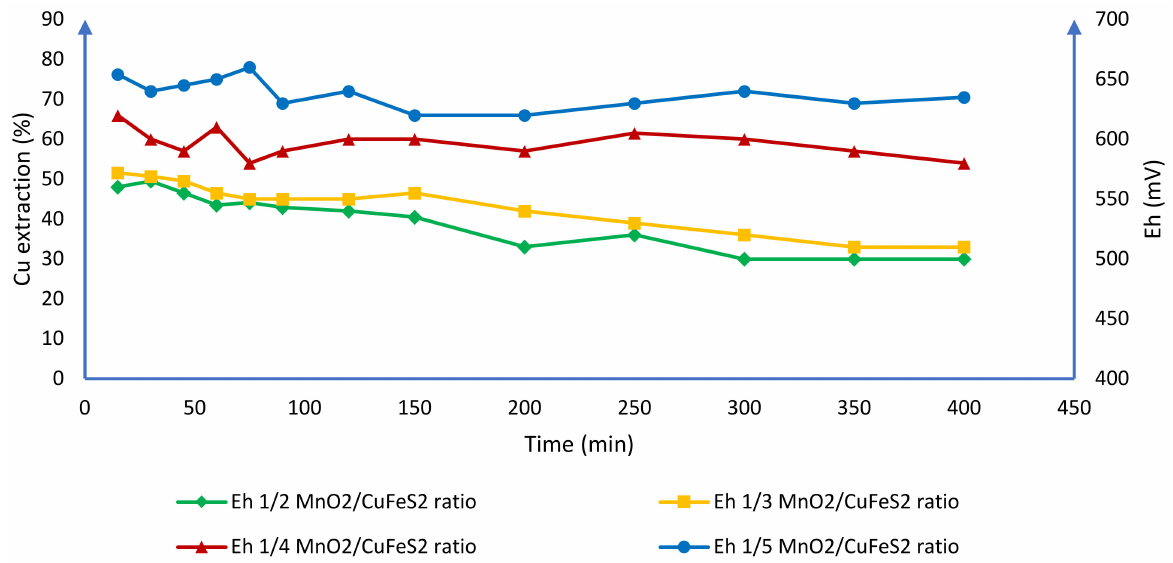
Figure 10. Effect of the potential in the solution of Cu at different ratios of MnO 2 /CuFeS 2